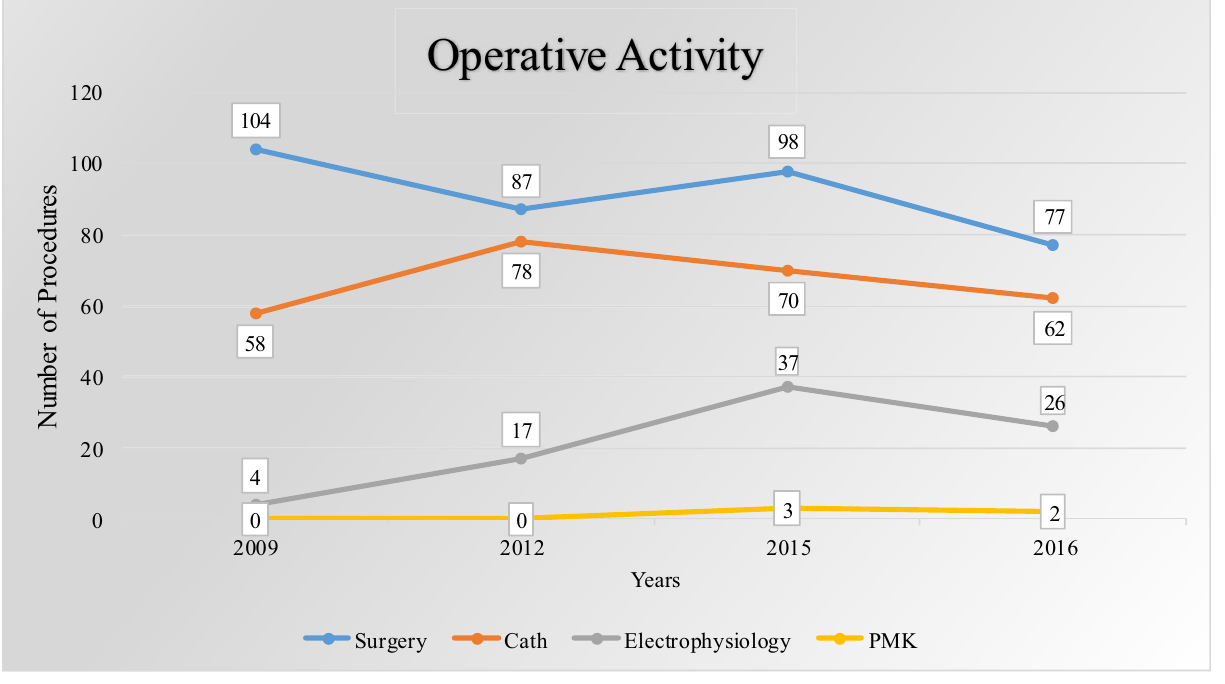
Operative Activity